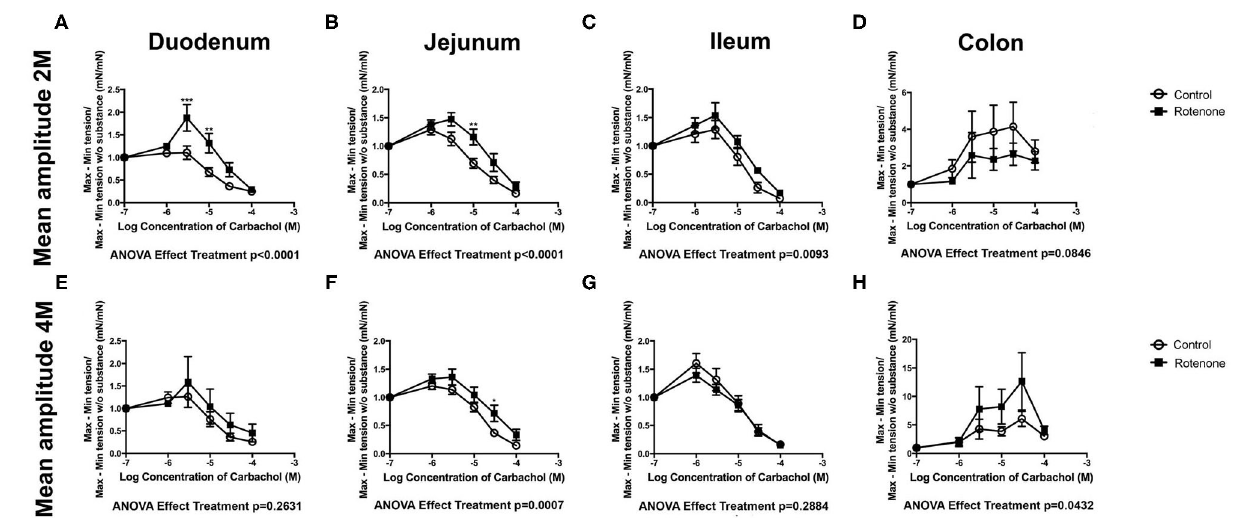
FIGURE 2 | Two- and 4-Month rotenone exposure in mice increases the sensibility to carbachol in duodenum and jejunum. Effect of carbachol treatment on the amplitude (mean amplitude) of the duodenum (A,E) , jejunum (B,F) , ileum (C,G) , and colon (D,H) from control or 2 or 4 months rotenone-exposed mice. Data was analyzed using a 2-way ANOVA and a Bonferroni post-hoc test. Values of the effect of exposure are shown under the corresponding graph. *, **, *** correspond to P < 0.05, P < 0.01, and P < 0.001, respectively for each concentration obtained with the Bonferroni post-hoc test. Error bars represent SEM in all graphics.